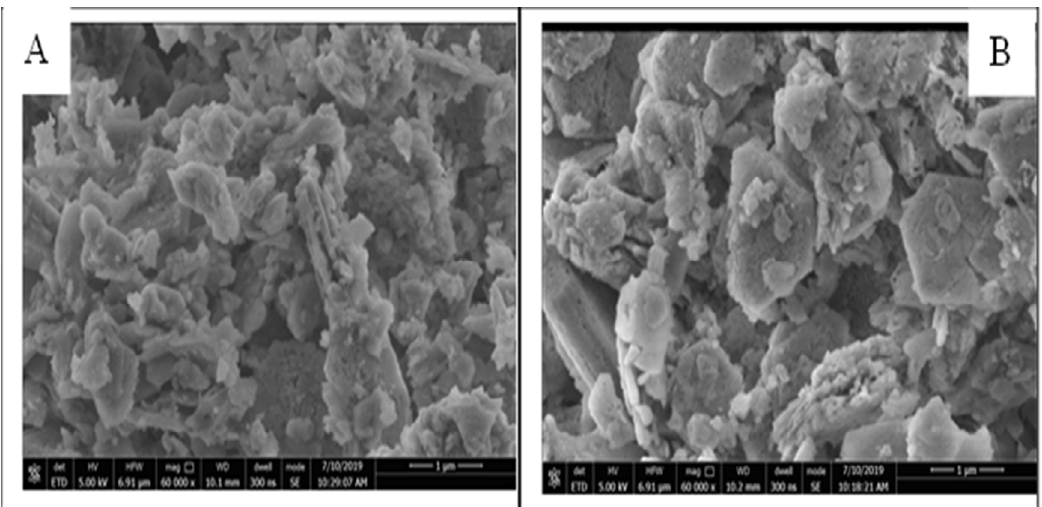
Fig. 6. SEM images of zinc aluminate samples synthesized by both SSR [A] and MSS